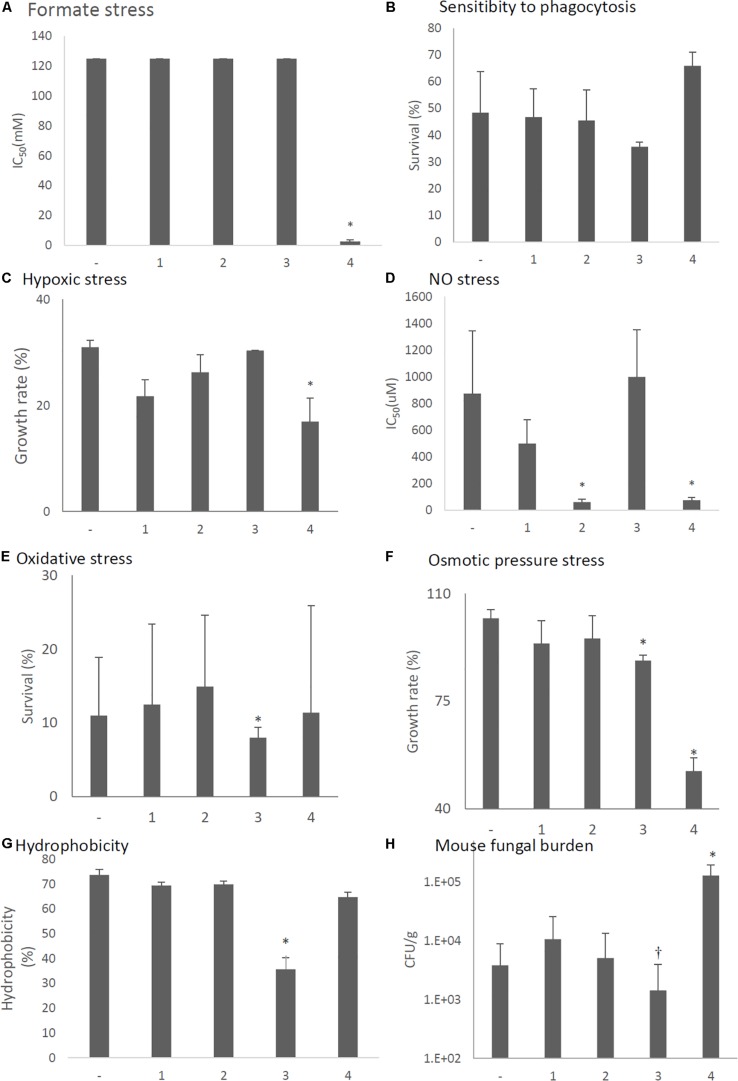
Comparisons of tolerance to stresses, response of mammalian cells, and virulence of ORF-expressing strains. -, KU strain carrying an empty vector. 1–4, KU strains with forced expression of each ORF. The labels are common from graphs (A) to (G). (A) IC50 of the strains under formate stress conditions (RPMI 1640 medium). (B) Sensitivity of the A. fumigatus strains to phagocytosis by J774A.1, a murine macrophage cell line. Techniques are described in the section “Materials and Methods.” (C) Growth of the fungal strains under hypoxic stress conditions. (D) IC50 of the strains under NO stress conditions (NOC-18 in RPMI 1640 medium). (E) Effect of hydrogen peroxide on the growth of the fungal strains. (F) Growth of the fungal strains under osmotic stress conditions. (G) Hydrophobicity. (H) The number of colonies per gram of lung tissue isolated from mice at 72 h after fungal infection. Data are presented as mean ± SD using four mice per group. ∗P < 0.05, †P < 0.15 (nominally not statistically significant). The labels are common from graphs (A) to (G). For graphs (B–G), data are presented as mean ± SD of three independent experiments. ∗P < 0.05, by one-way ANOVA, Dunnett’s test. The data without “∗” were NS in comparison to control (KU strain carrying an empty vector).